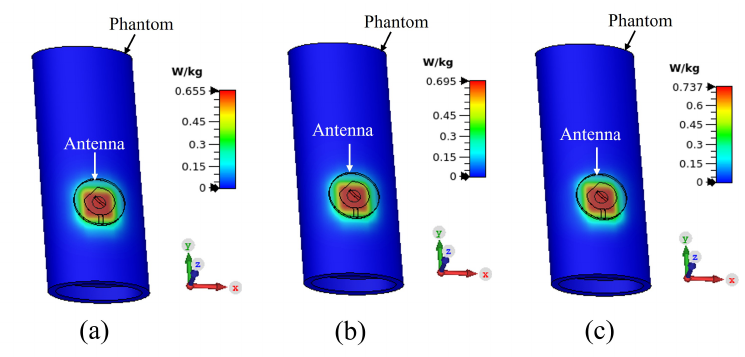
Figure 18. SAR distributions in the forearm phantom at: ( a ) 2.4 GHz, ( b ) 2.45 GHz and ( c ) 2.6